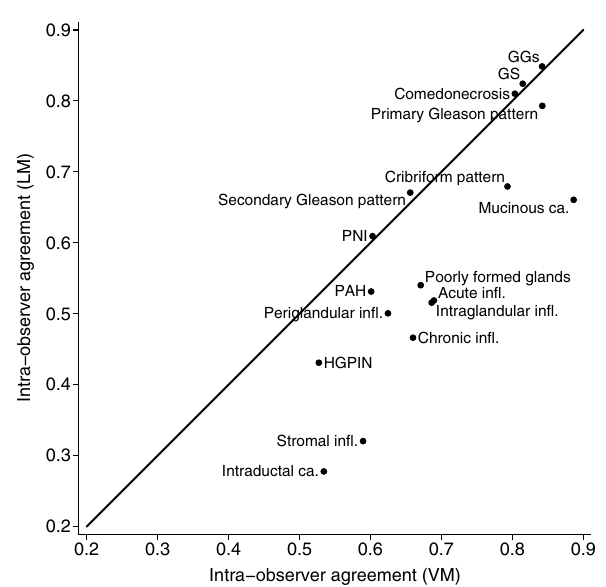
Figure 1. Repeatability plot for all characteristics evaluated on the core and slide level. Note: Intra-observer agreement refers to the agreement of the Reviewer 1.1 vs. Reviewer 1.2. LM light microscopy; VM virtual microscopy; GGs Gleason Grade Groups; GS Gleason score; PNI perineural invasion; PAH postatrophic hyperplasia; HGPIN high-grade prostatic intraepithelial neoplasia; infl Inflammation; ca